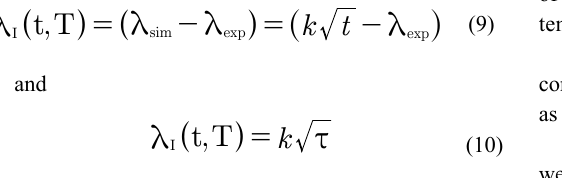
Where k is the growth rate constant, the variable λ represents the thickness corresponds to the incubation time (µm), λ is the simulated thickness with τ=0 and the λ sim thickness is experimentally obtained.